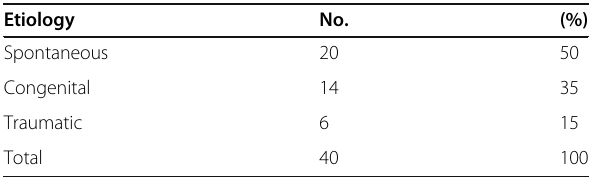
Table 3 Etiologies of CSF